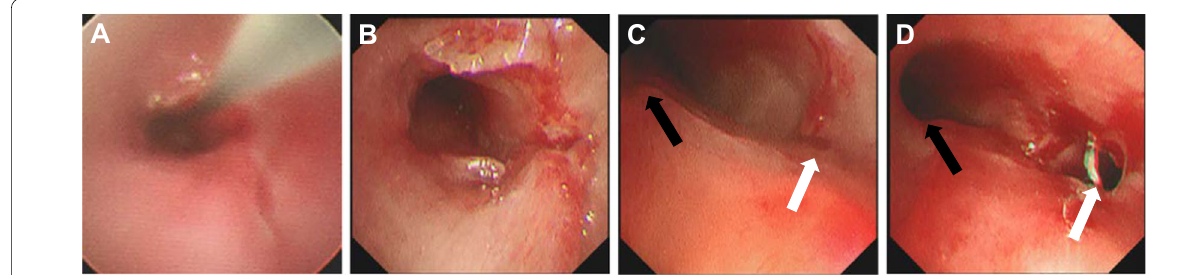
Fig. 3 Bronchoscopic findings of anastomosis. A , B Stenosis of the anastomosis between the trachea and left main bronchus. A Before treatment, with wires for balloon dilation. B After treatment. C , D Stenosis of the anastomosis between the left main bronchus (black arrow) and right main bronchus (white arrow). C Before treatment. D After